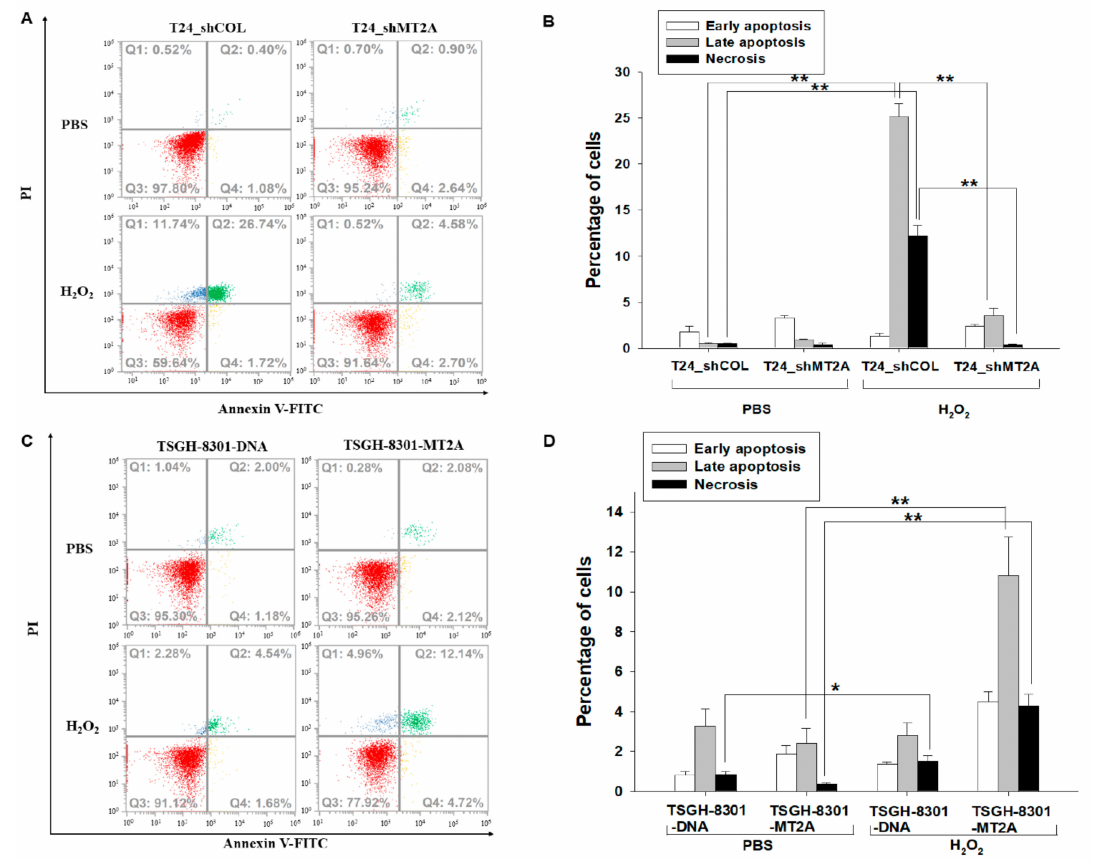
Figure 3. MT2A enhances H 2 O 2 treatment-induced cell apoptosis in bladder carcinoma cells.